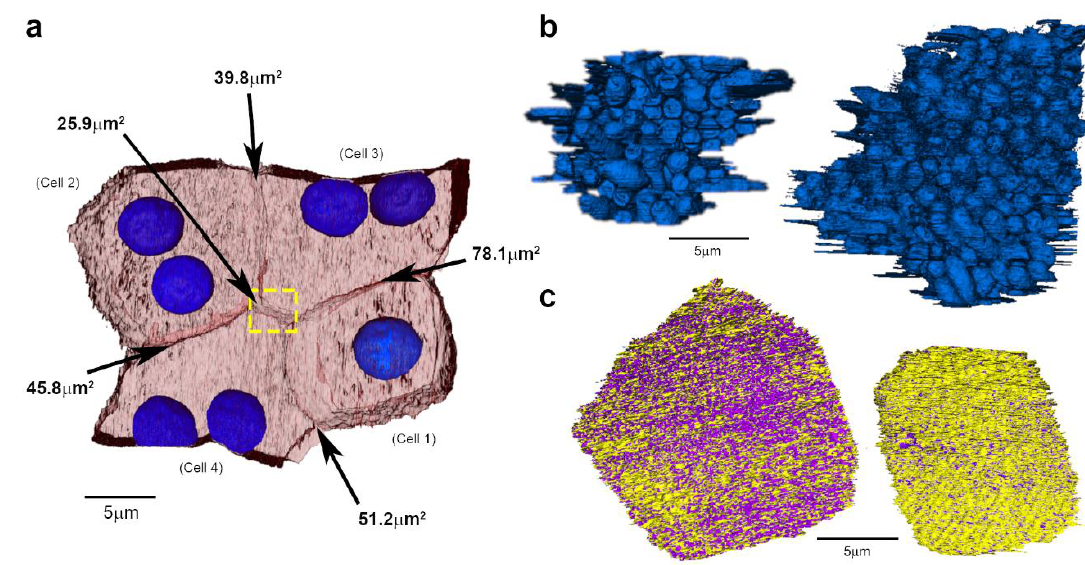
Figure 2. SBF-SEM of outer retinal morphology in the adult mouse. ( a ) Top–down view of 3D-reconstructed RPE monolayer indicating (arrows) contact area between neighbouring cells. The contact area at each interface is shown alongside. Individual cells are assigned numbers, which correspond to those in Figure 1f and in Figure S1c. ( b ) Bottom–up view showing the number of photoreceptors interacting with mono-nucleate (left) and bi-nucleate (right) RPE cells. ( c ) Top–down view of bi-nucleate (left) and mono-nucleate (right) cells showing infolds in the yellow basolateral membrane. Purple indicate sub-RPE spaces. Scale bars = 5 µm.